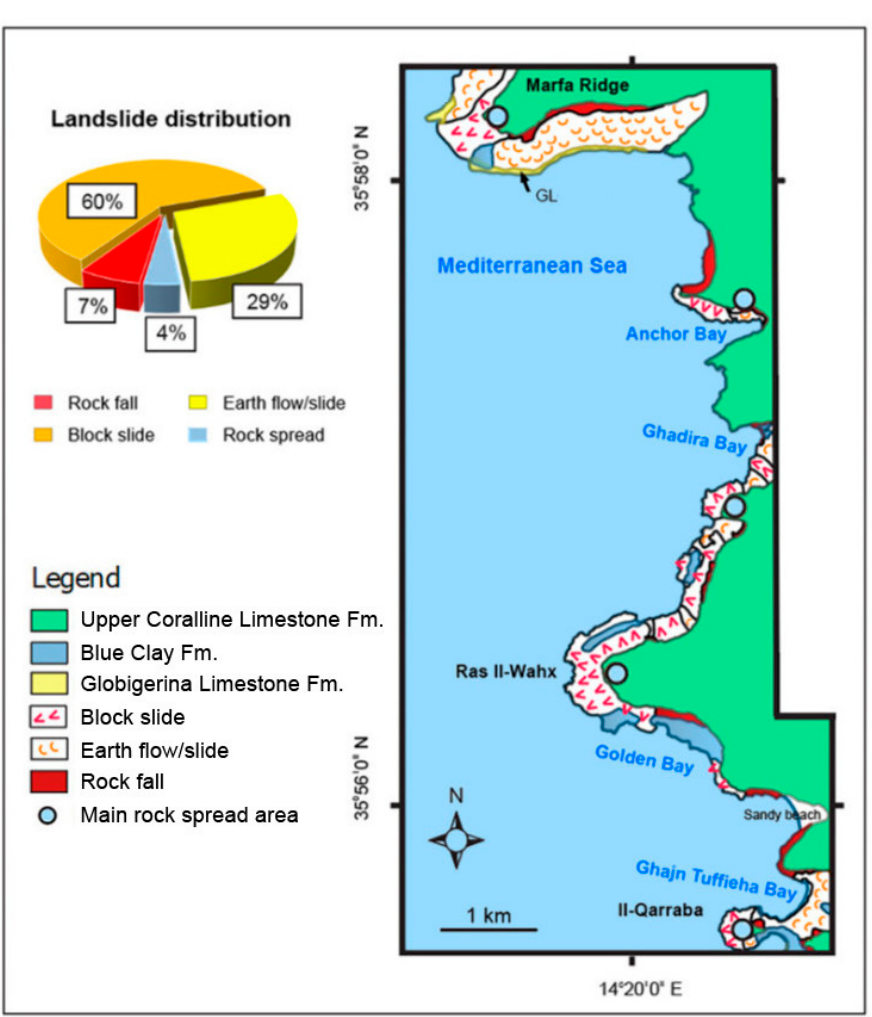
Figure 2. Landslide distribution along the northwestern coast of the island of Malta.